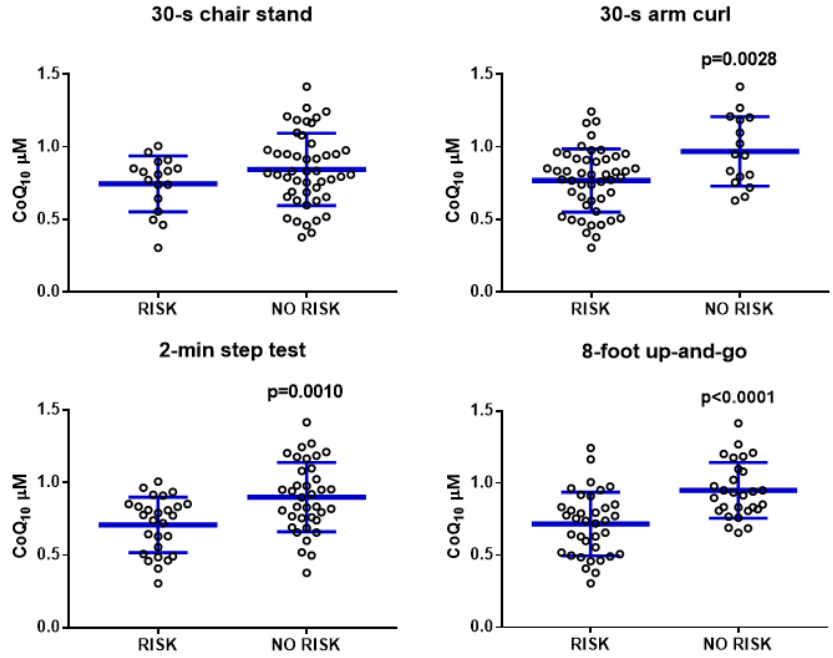
Figure 4. Relationship of blood plasma CoQ10 levels with frailty risk. Blood plasma CoQ 10 levels ( µ M) are related to frailty risk, based on the four tests included in the SFT, which showed a direct relationship with CoQ 10 levels. Data represent the mean ± SD of the whole population (n = 64).